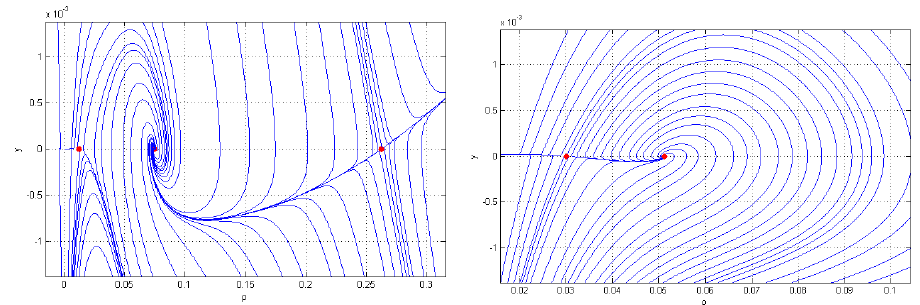
Fig. 1. Trajectories in y  phase plane with the parameters: (a) 371.1  c and 36.0  q 38.1  c and 80.0 *